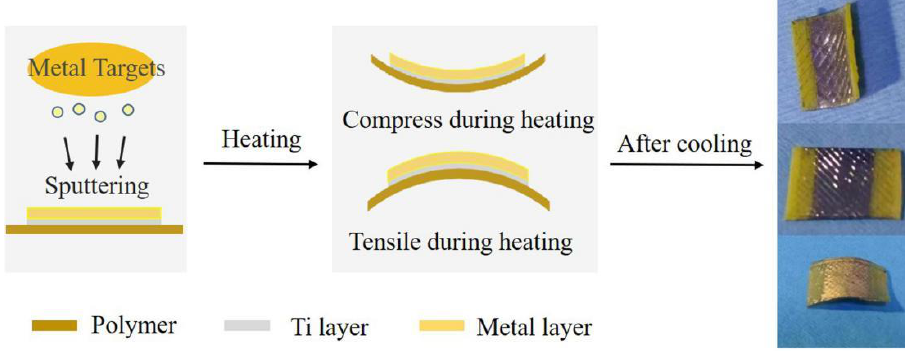
Figure 6. Schematic diagram showing the preparation of strained metal.